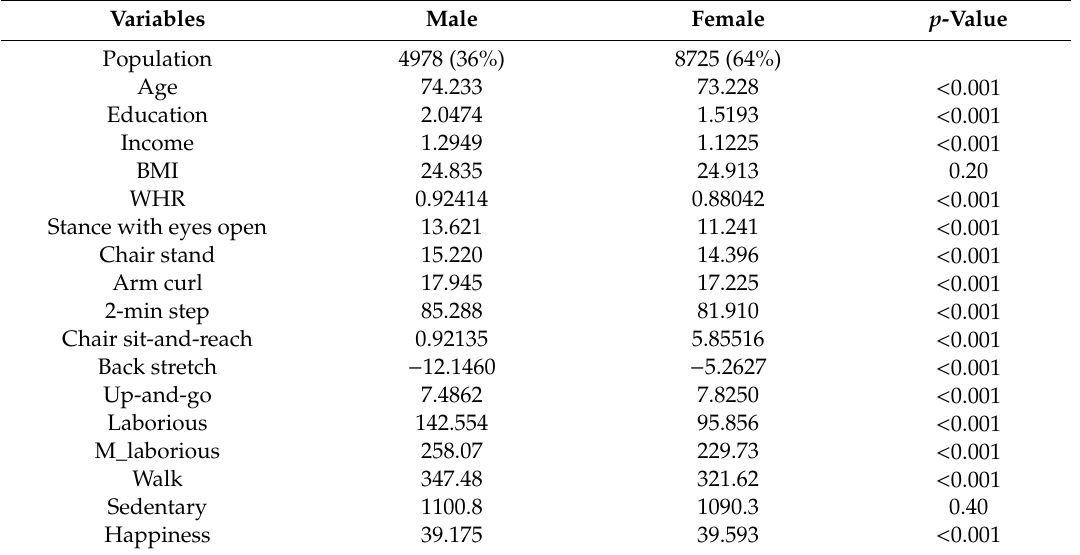
Table 1. Results of t -tests for